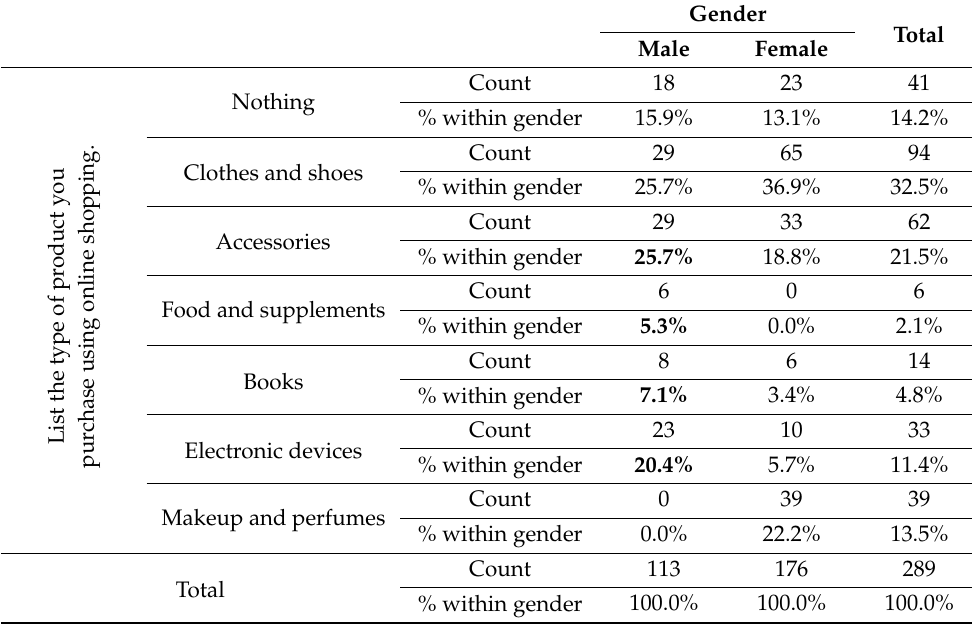
Table 4. Types of goods purchased online by gender.